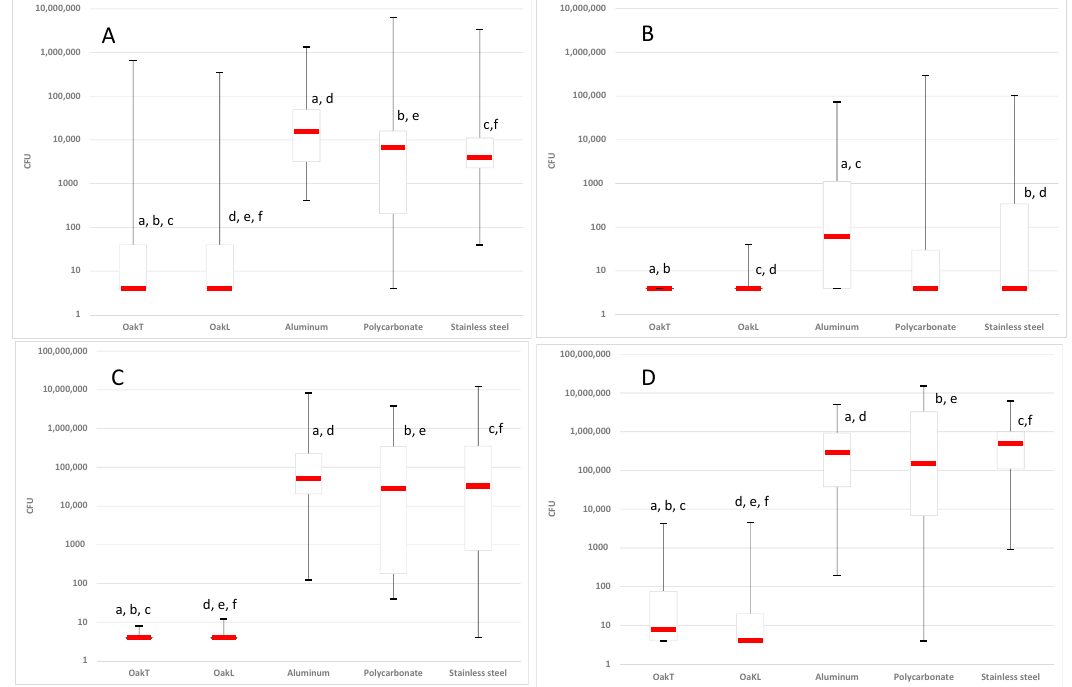
Figure 2. Box plot representing viable bacteria count distribution (from day 0 to day 15) for Klebsiella pneumoniae ATCC 700603 ( A ) with significant differences reported according to Dunn’s Multiple Comparison Test: (a) oakT vs. aluminum p ≤ 0.001; (b) oakT vs. polycarbonate p ≤ 0.01; (c) oakT vs. stainless steel p ≤ 0.001; (d) oakL vs. aluminum p ≤ 0.001; (e) oakL vs. polycarbonate p ≤ 0.01; (f) oakL vs. stainless steel p ≤ 0.001, Acinetobacter baumannii ATCC 19606 ( B ) with significant differences reported according to Dunn’s Multiple Comparison Test: (a) oakT vs. aluminum p ≤ 0.001; (b) oakT vs. stainless steel p ≤ 0.01; (c) oakL vs. aluminum p ≤ 0.001; (d) oakL vs. stainless steel p ≤ 0.05 ( C ) with significant di ff erences reported according to Dunn’s Multiple Comparison Test: (a) oakT vs. aluminum p ≤